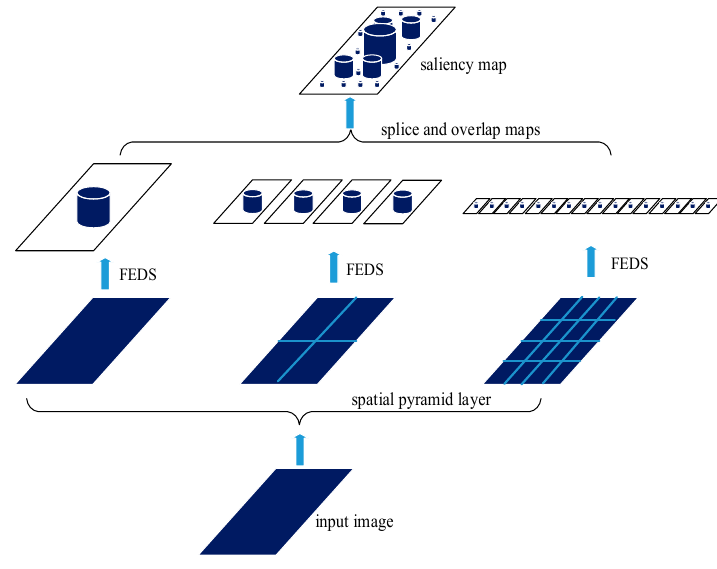
Figure 3. The flow chart of the SPGKDE.